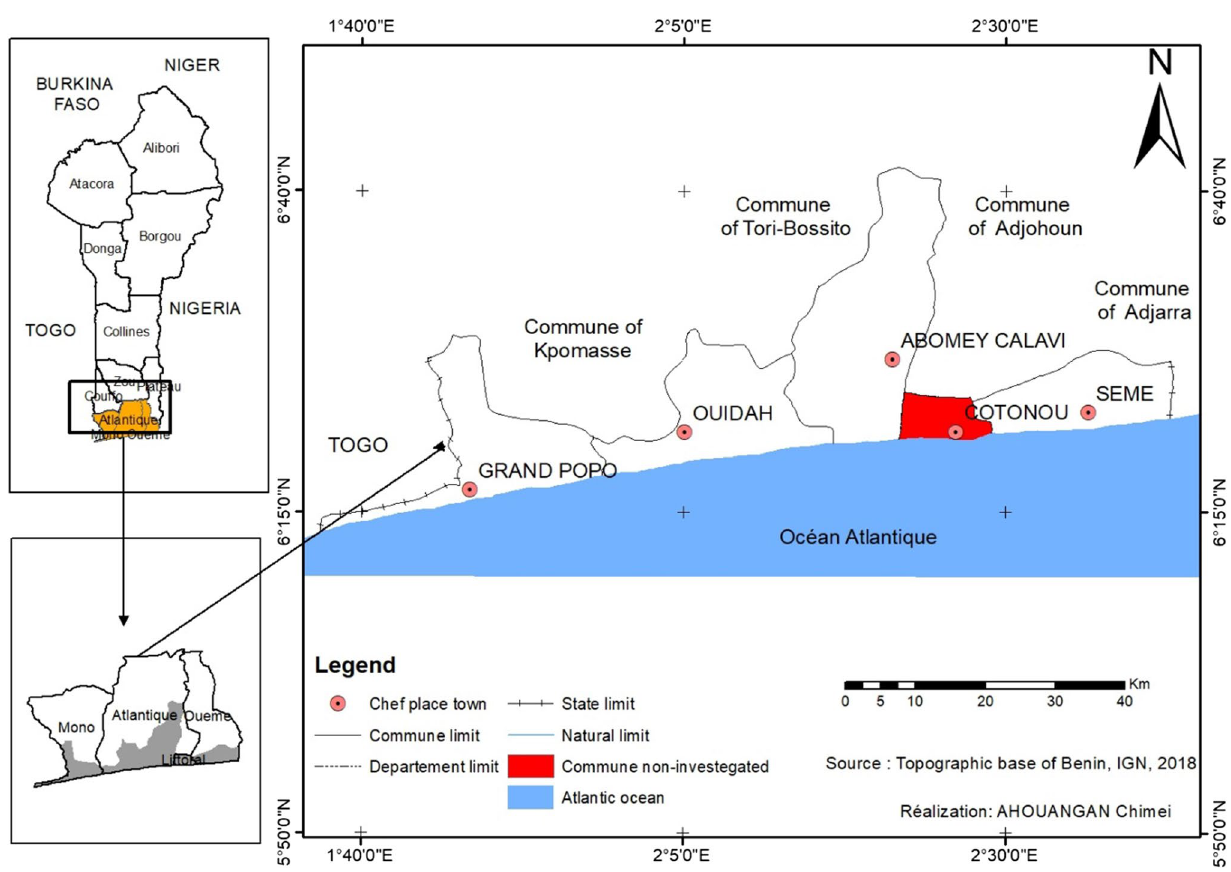
Fig. 1 Map of the study area showing the studied municipalities (Semè-Podji, Abomey-Calavi, Ouidah,